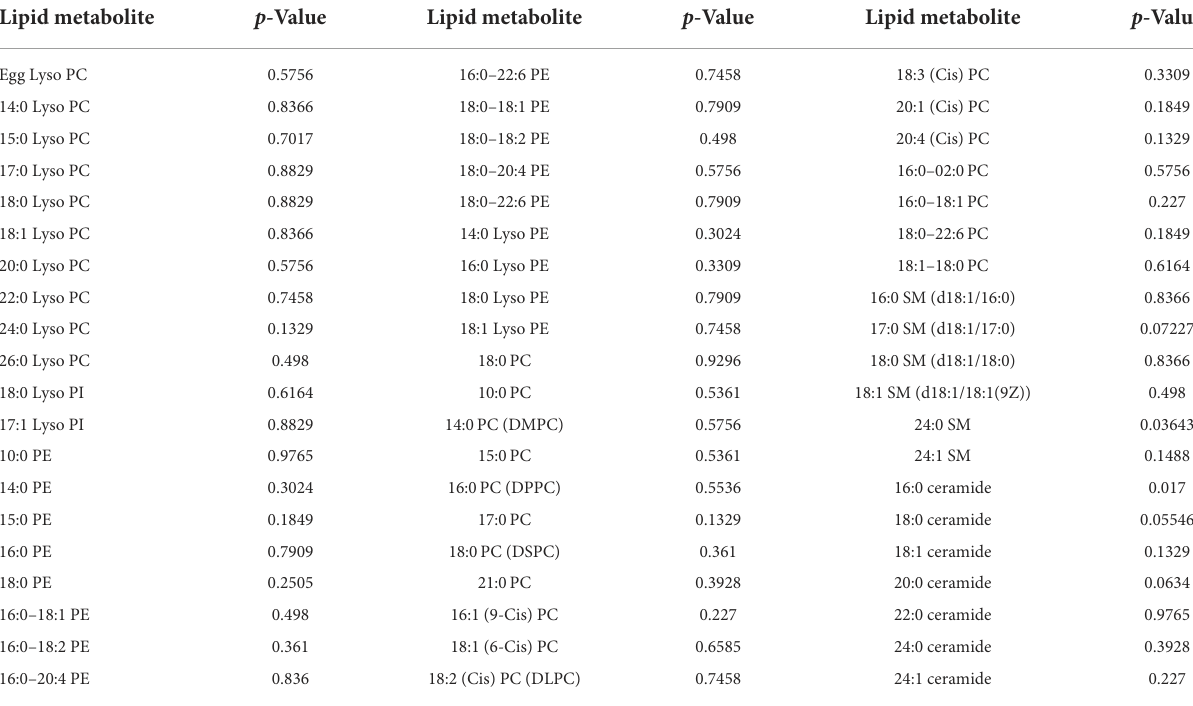
TABLE 4 Differences in lipid metabolite concentrations between high-grade and low-grade fatty infiltration groups.